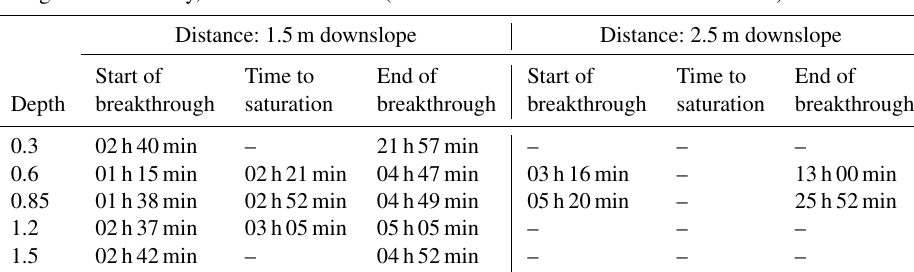
Table 3. Characteristic breakthrough times at different depths for the second irrigation. Irrigation II: 29 May, 09:18–13:53CEST (duration: 4h35min – 700l ≈ 67.9mmh − 1 ) Distance: 1.5m downslope Distance: 2.5m downslope Start of Time